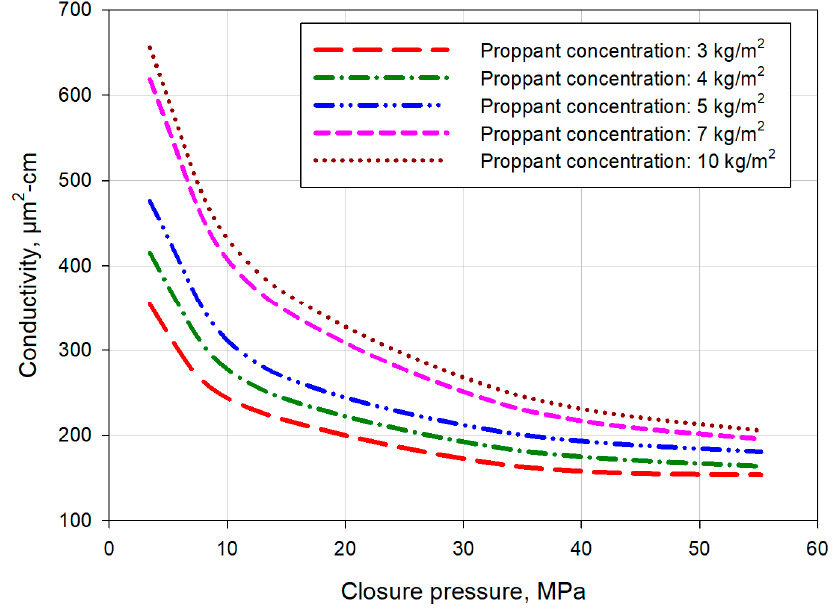
Figure 8. Conductivity evolution of cruciform intersecting pattern fractures with different proppant concentrations.